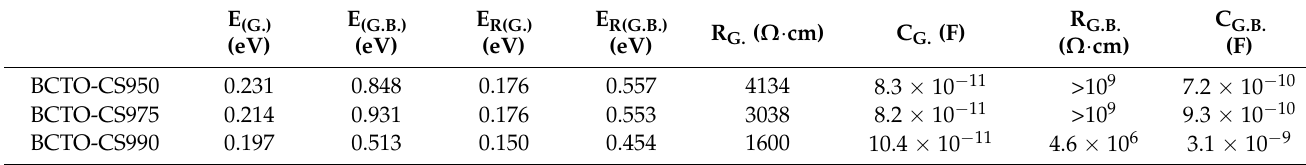
Table 2. Activation energy values for conduction (E) and for relaxation process (E R ) in grain (G.) and grain boundary (G.B.); the resistivity of grain (R G. ) and grain boundary (R G.B. ); and the capacitance of grain (C G. ) and grain boundary (C G.B. ) for BCTO